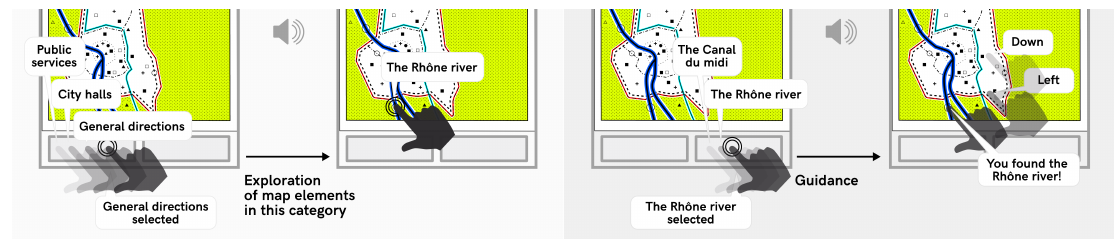
Figure 2. A swipe on the bottom left menu followed by a double tap allows the user to define the category of geographical information to display (e.g., cities). Then, the user can choose a specific point of interest within the current category, and is guided towards it with a second menu at the bottom